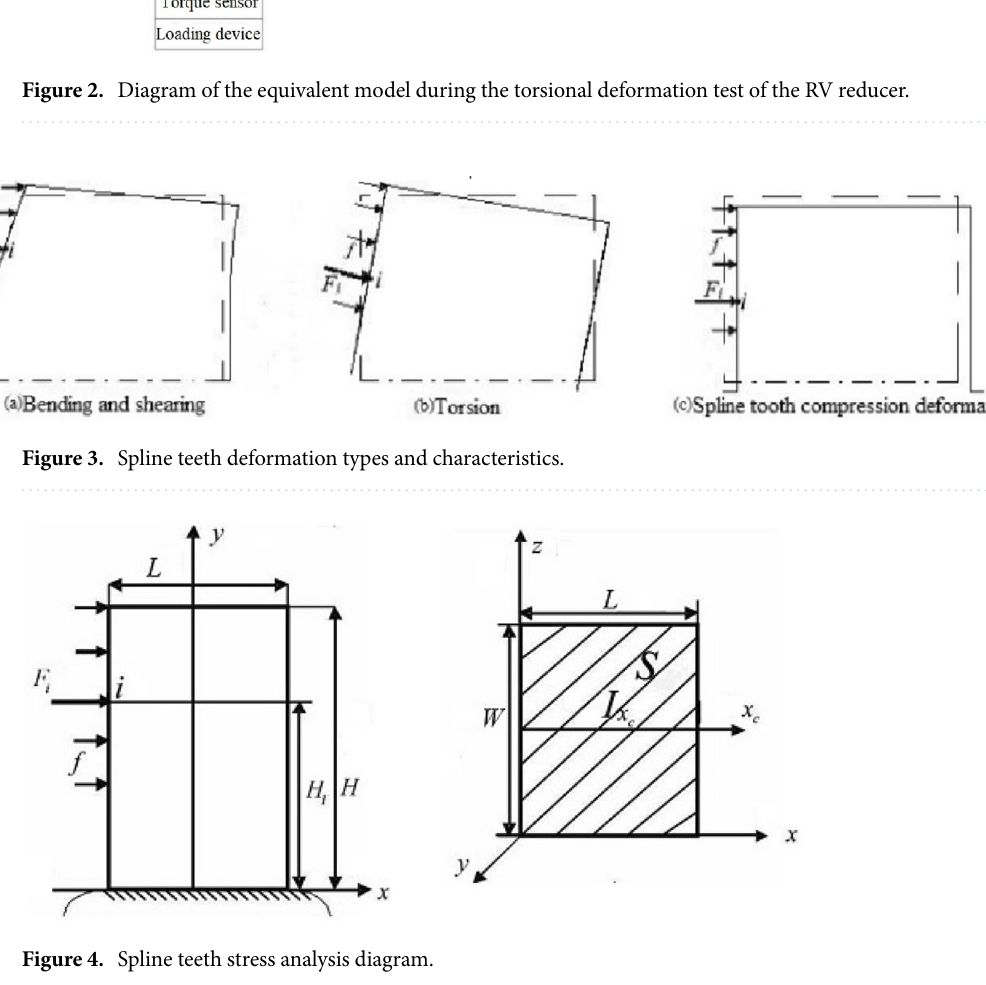
Figure 4. Spline teeth stress analysis